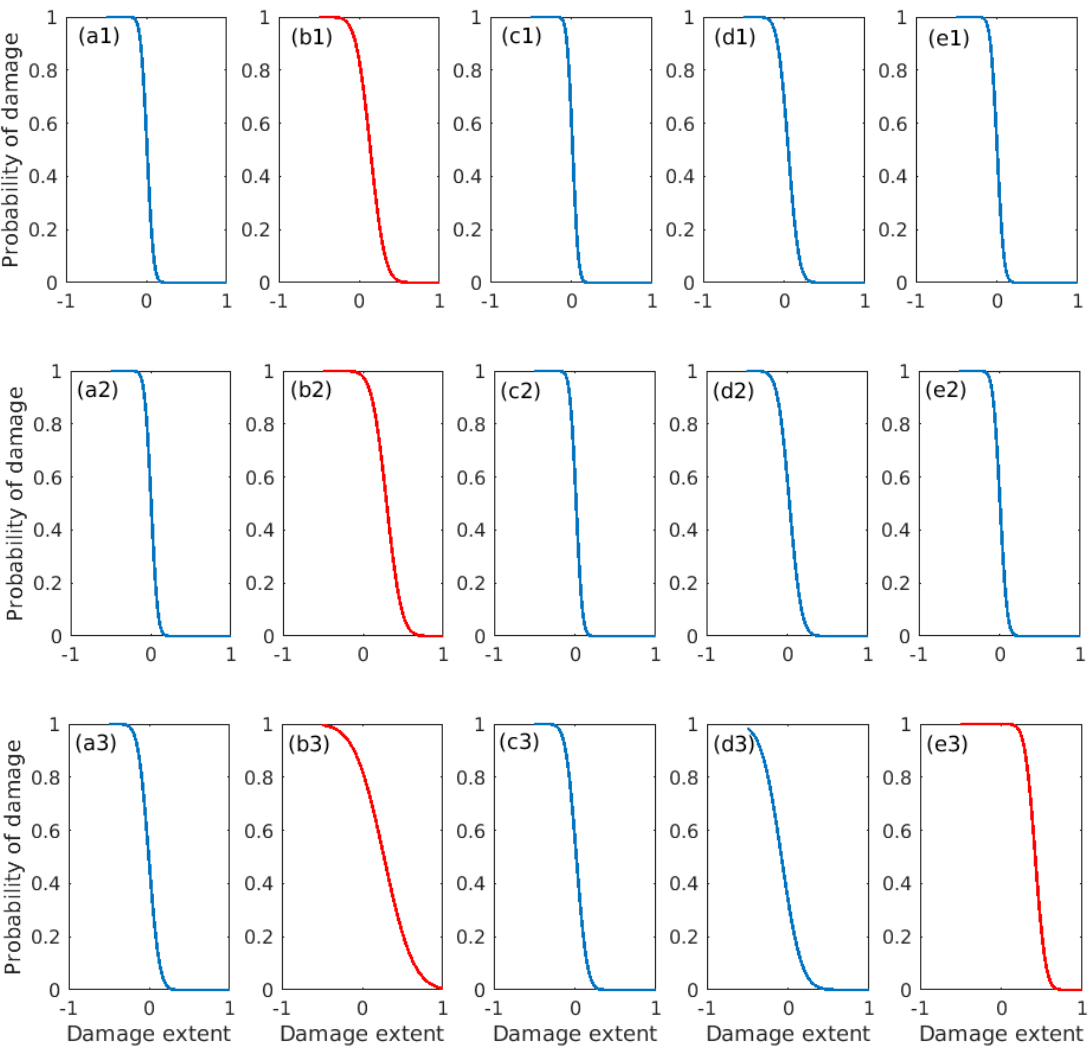
Figure 8. Probability of damage: ( a1 ) − ( e1 ) Case 1; ( a2 ) − ( e2 ) Case 2; ( a3 ) − ( e3 ) Case 3.